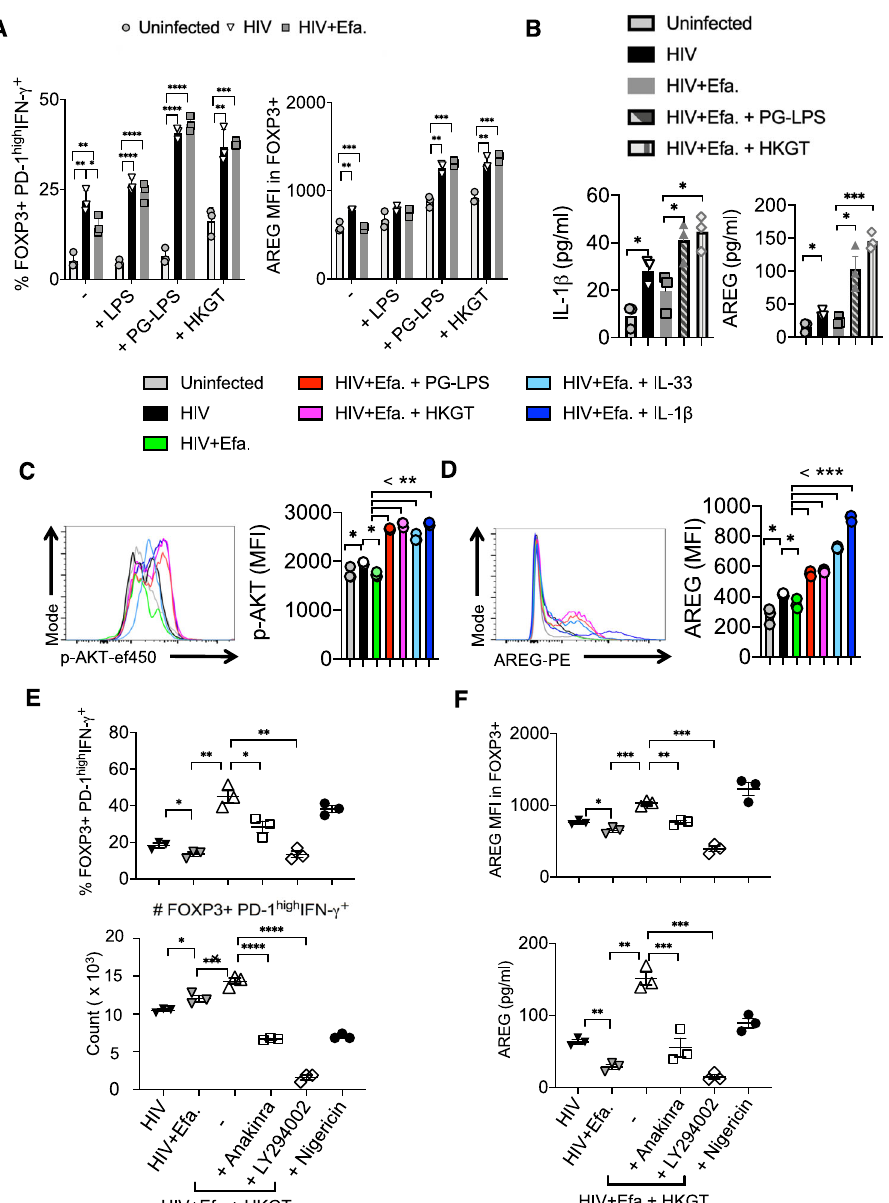
Fig. 5 PD-1 hi IFN- γ + FOXP3 + cell induction is associated with the expression of IL-1 β -dependent AKT1 signaling and enhanced by TLR2 ligands in the context of HIV infection. Puri fi ed tonsil CD4 + T cells (~93% purity) were TCR activated, infected with HIV, and allowed to expand in the presence of TGF- β 1 (10ng/ml) and IL-2 (100U/ml) for 6 days post-infection unless otherwise noted. Efavirenz (50nM), LPS (10 μ g/ml), PG-LPS (5 μ g/ml), HKGT (10 6 /ml), IL-1 β (20ng/ml), IL-33 (20ng/ml), Anakinra (10 μ g/ml), LY294002 (10 μ M), and Nigericin (10nM) were added as indicated, 36h post infection. A PD-1 and IFN- γ (left) and AREG (right) expression in FOXP3 + cells. B ELISA quanti fi cation of IL-1 β (left) and AREG (right) in cell culture supernatants collected on day 3 post infection. p-Akt ( C ) and AREG ( D ) expression in FOXP3 + cells. E Percentage and absolute cell numbers of PD-1 hi IFN- γ + FOXP3 + cells in CD4 + population. F AREG expression in FOXP3 + cells (left) and ELISA quanti fi cation of AREG (right), 6 days post infection. A – F Data are representative of three independent experiments and are presented as mean value + / − SEM. (* P <0.05; **<0.005, ***<0.0005, ****<0.00005; unpaired t tests). Source data are provided as a Source data fi